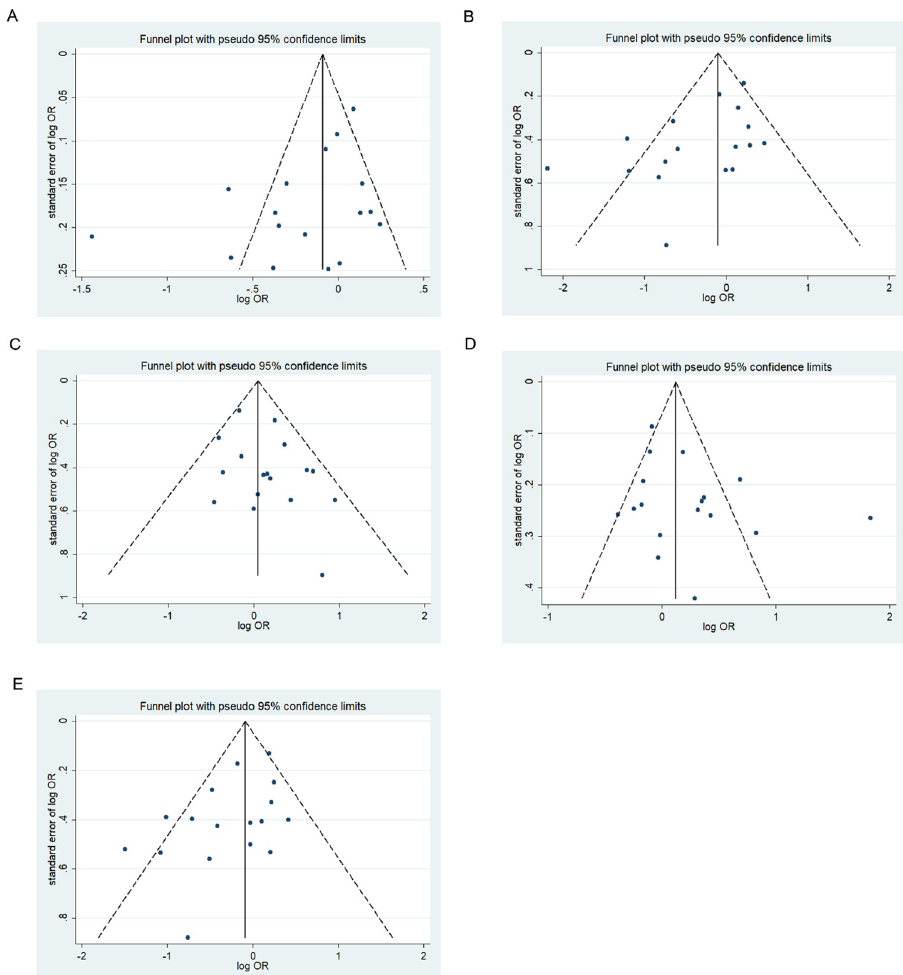
Fig 10. Funnel plot analysis depicting publication bias in the association between MTHFR 677C > T polymorphism and bipolar disorder in the five genetic models (A, allele contrast; B, homozygous codominant; C, heterozygous codominant; D, dominant; and E,